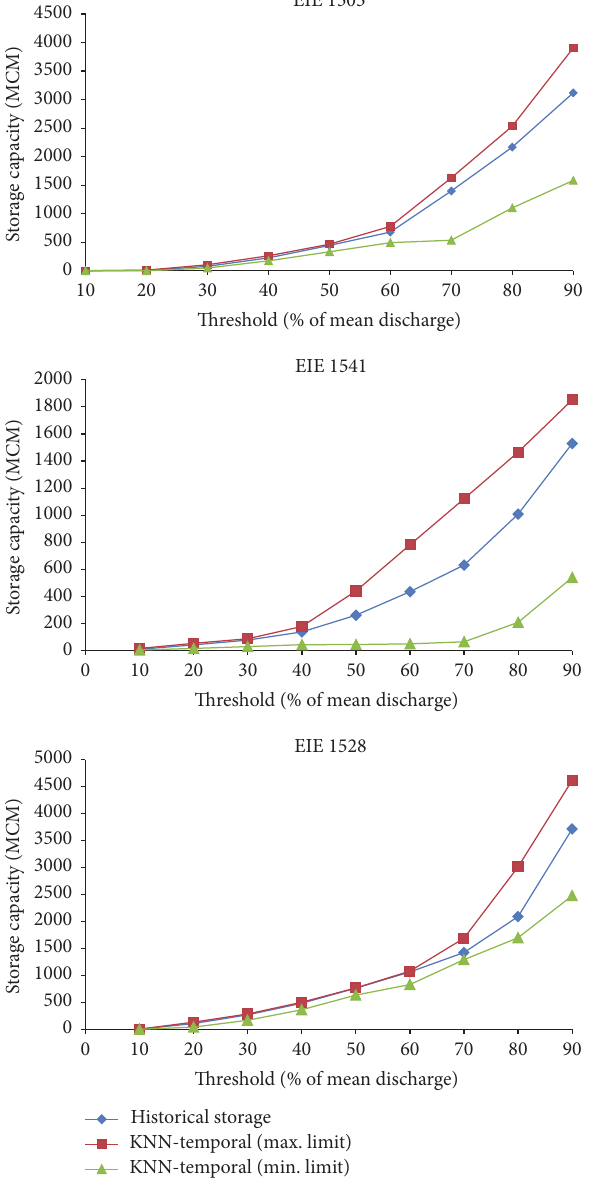
Figure 11: Monthly historical storage capacity and its limits calcu- lated from the spatial approach at all stations.